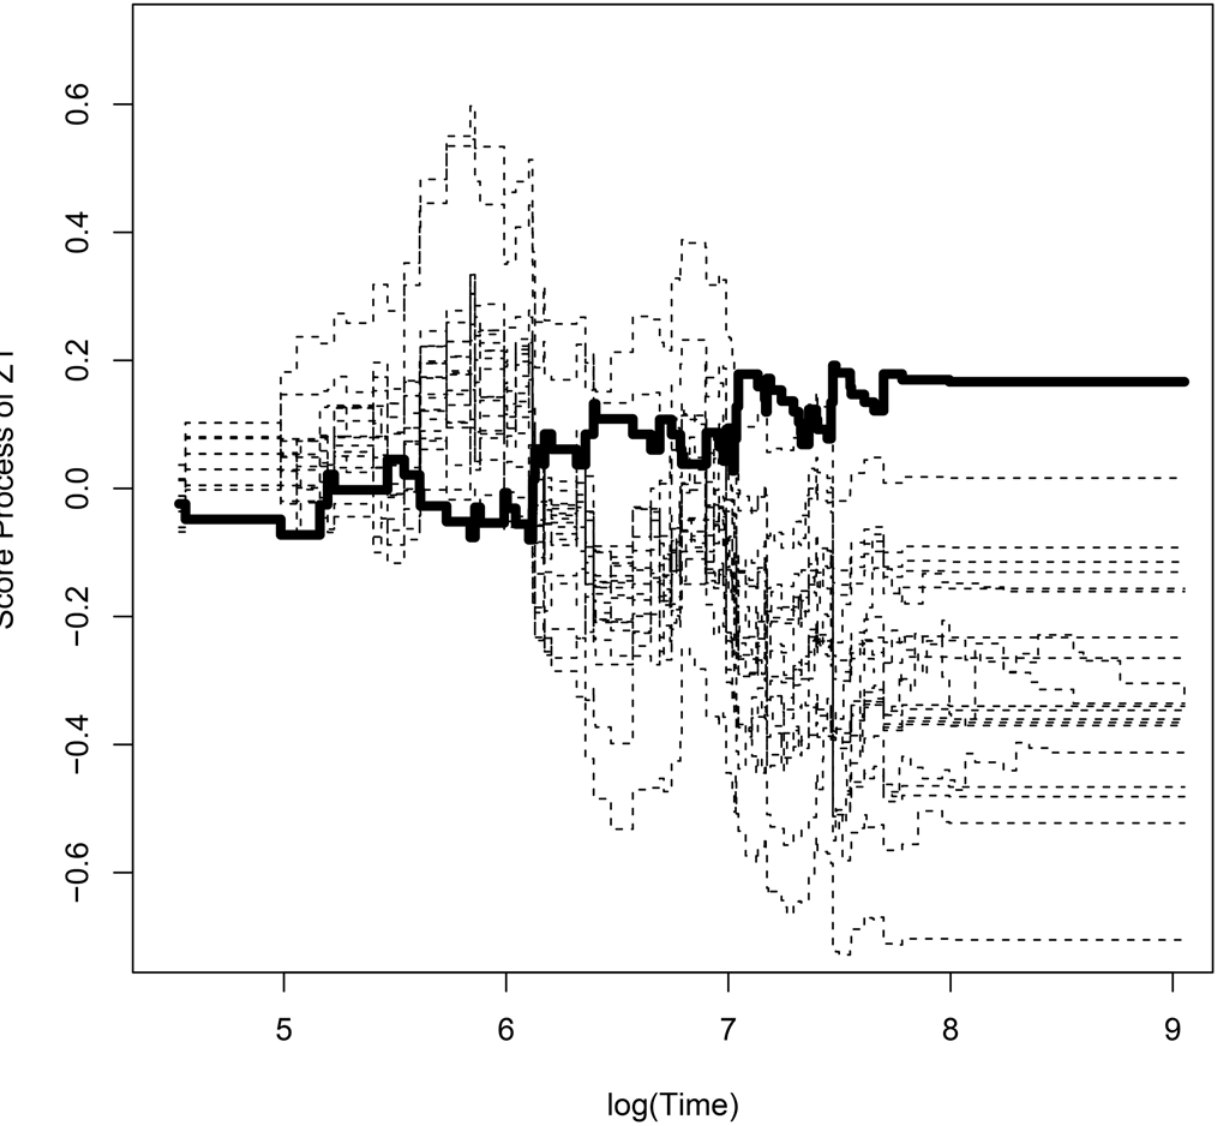
Fig 3. Plot of observed score process and bootstrapped processes of time to first virologic failure using ^ α P with respect to Z 1 . The thickline is observed process and the dashed lines are bootstrapped processes